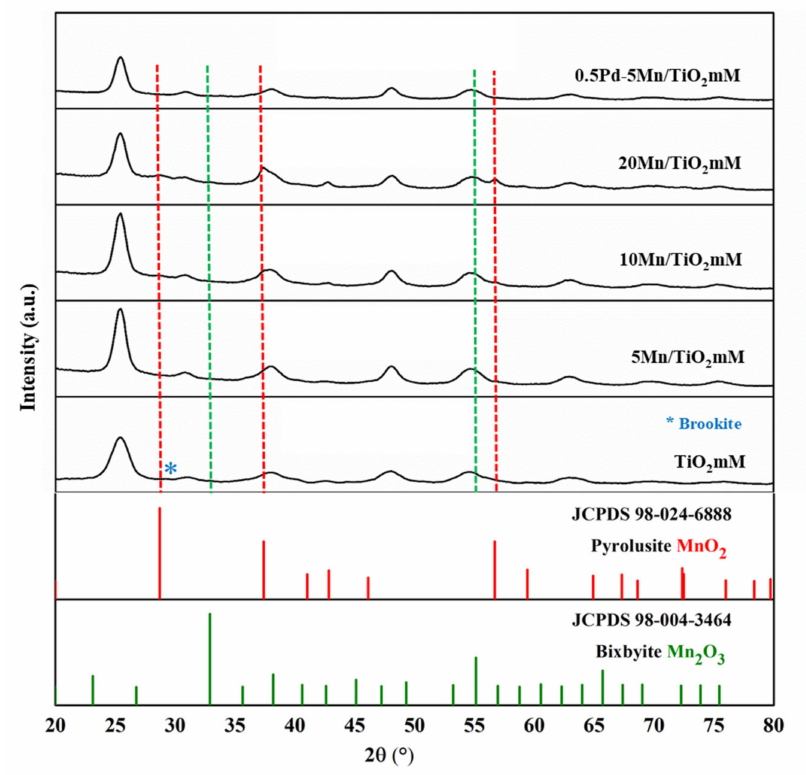
Figure 1. Wide-angle XRD patterns of the hierarchical meso–macroporous TiO 2 mM support and the corresponding supported Mn and Pd samples (all calcined at 400 ◦ C). Bottom: JCPDS references MnO 2 and Mn 2 O 3